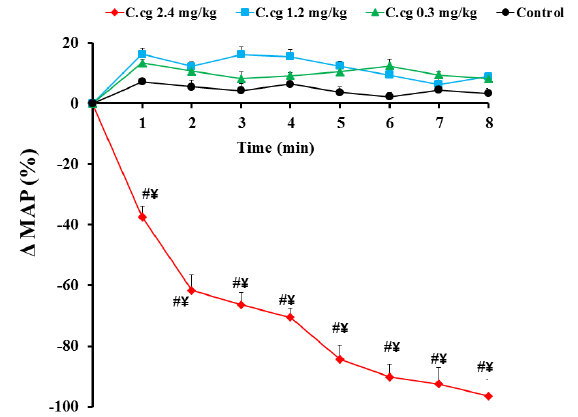
Figure 3. Changes in mean arterial pressure after intravenous administration of Cerastes cerastes gasperettii venom (300, 1200 and 2400 µg/kg). Control rats (n=5) received normal saline (400 µL, i.v). The points represent the mean ± SEM. #,¥ P < 0.01 compared to the elementary value (time zero) of the same group and (#) to the control group